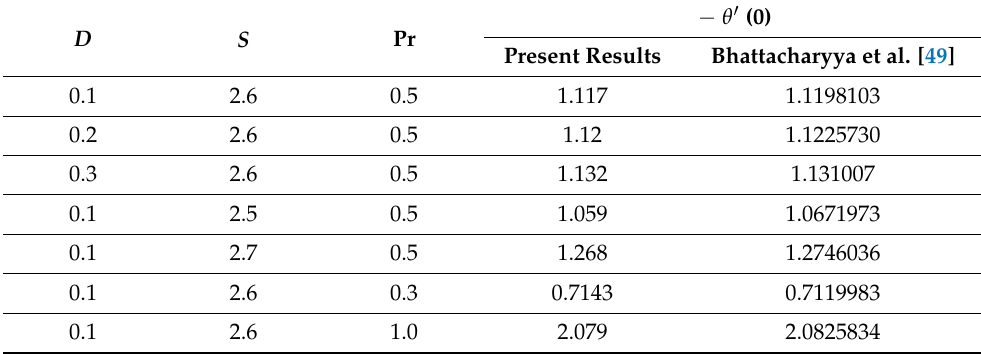
Table 3. Comparison of Local Nusselt number (rate of heat transfer) with Bhattacharyya et al. [49] for several values of curvature parameter, suction parameter and Prandtl number when φ = A